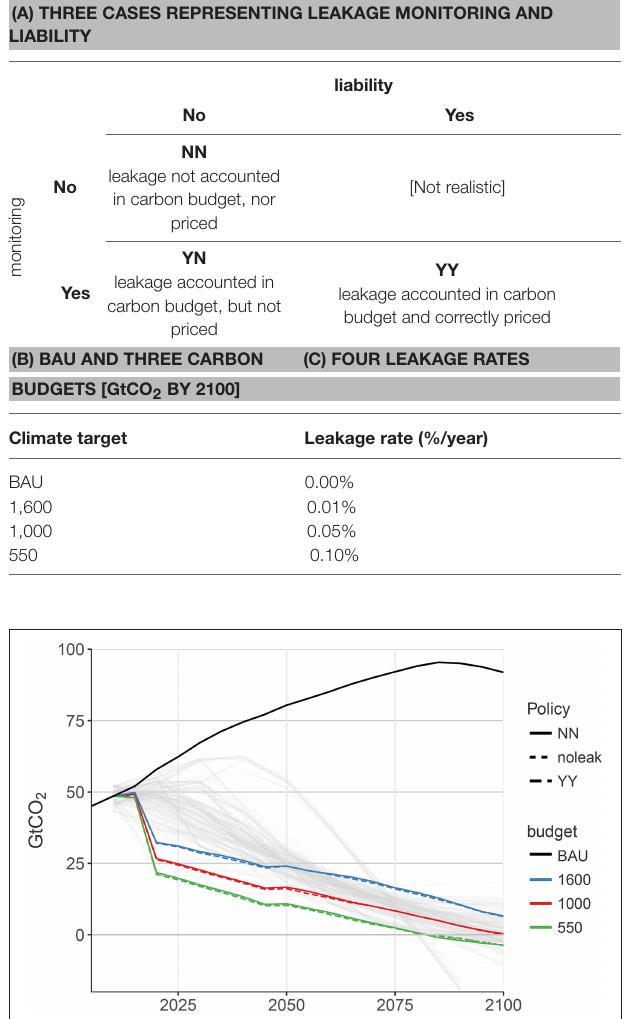
TABLE 1 | Scenarios considered (31 in total).